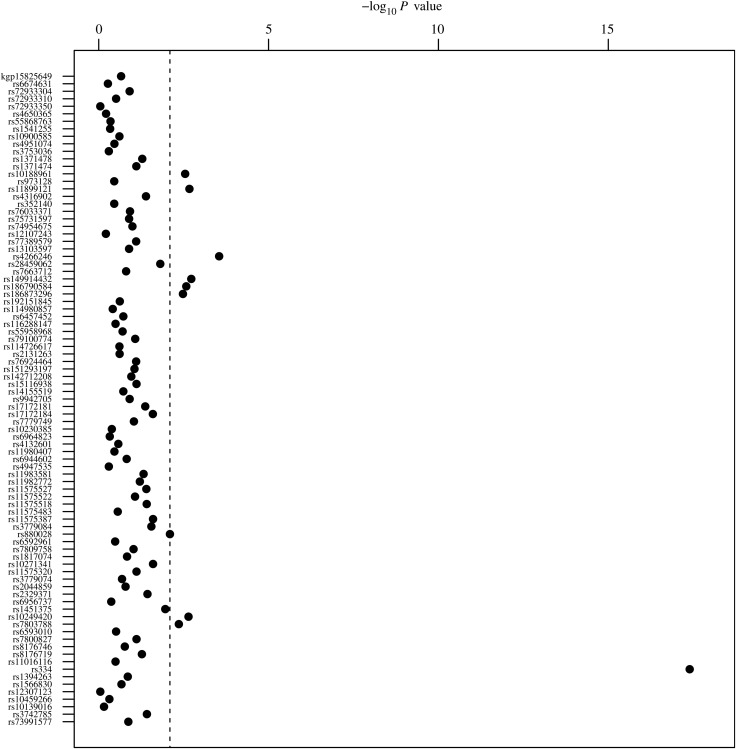
Association P values for severe malaria. Vertical dashed line represents P value of .008.